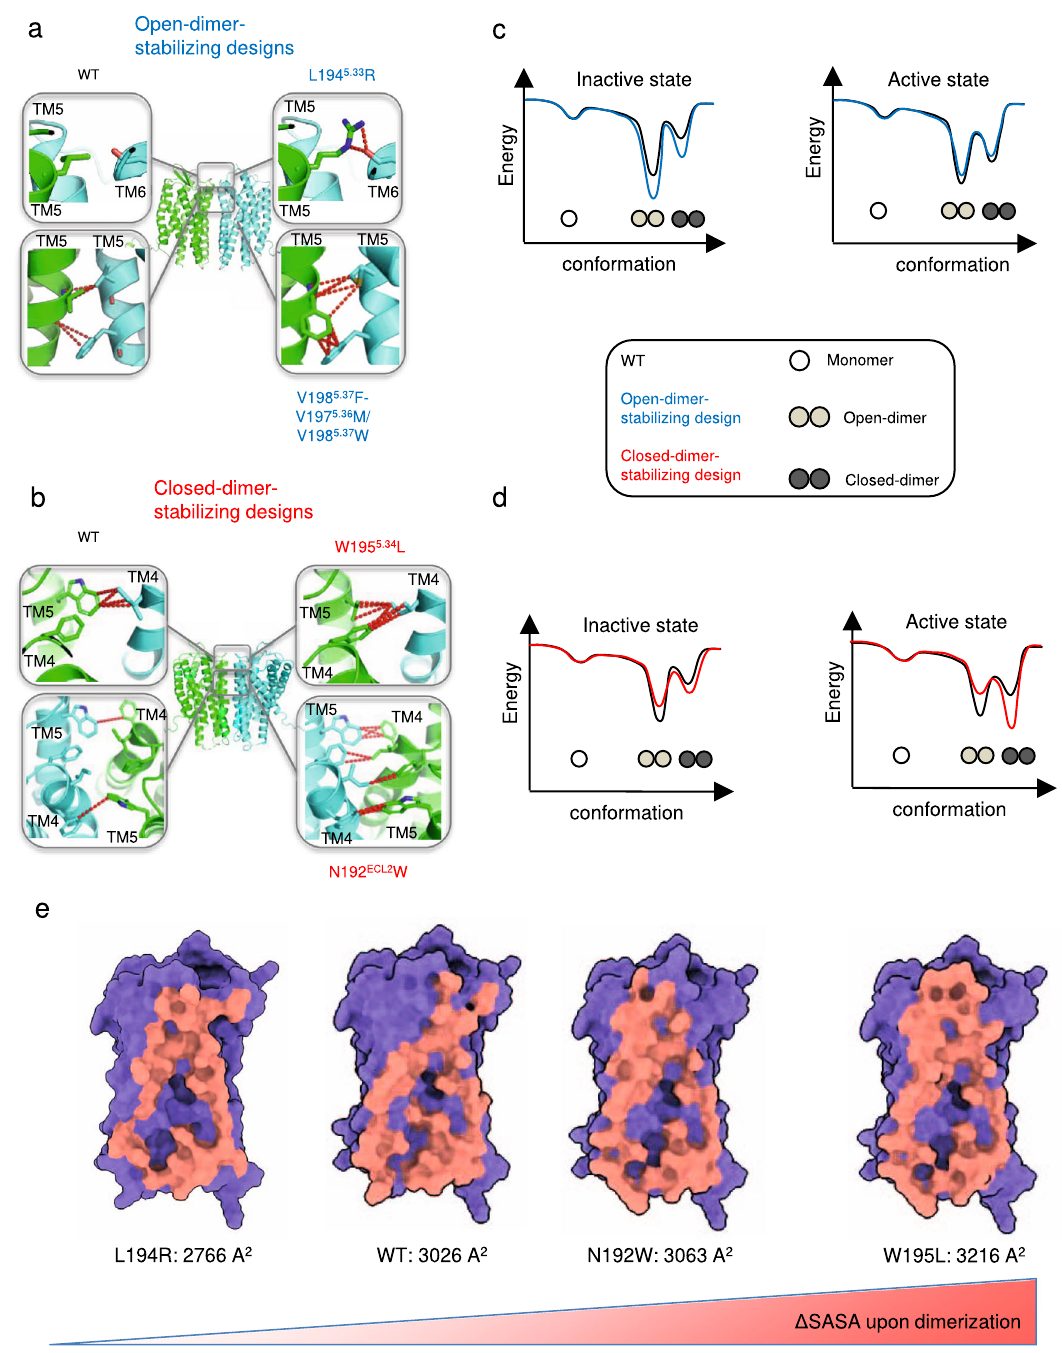
Fig. 2 | Computational design of CXCR4 associations with speci fi c conforma- tions. a Mutations designed to selectively stabilize the CXCR4 open-dimer con- formation without affecting CXCR4 monomer stability were identi fi ed in the extracellular and TMH regions. b Mutations designed to selectively stabilize the CXCR4 closed-dimer conformation without affecting CXCR4 monomer stability were identi fi ed in the extracellular region. Key atomic contacts are represented as red dotted lines. c Schematic conformational energy landscapes of CXCR4 dimerizationintheinactiveandactivestatesfortheopen-dimerstabilizingdesigns. d Schematic conformational energy landscapes of CXCR4 dimerization in the inactive and active states for the closed-dimer stabilizing designs. c , d The